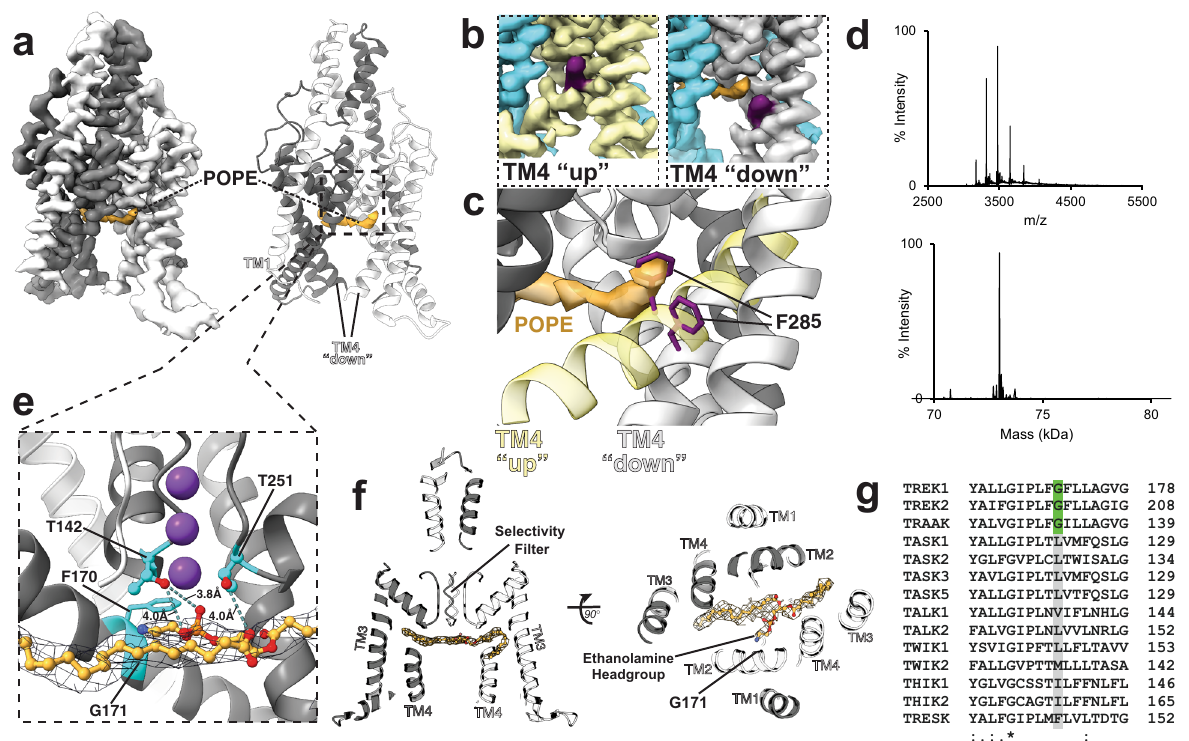
Fig. 5 | Head fi rst pore block by POPE lipids. Cryo-EM map and matching struc- tural model of TREK1 in DDM supplemented with POPE ( a ), highlighting the loca- tionofasinglePOPElipid (orange)boundwithinthe pore.The lipid densityshown isderivedfromthesharpenedmapofthe fi nalre fi nementbeforeC2symmetrywas applied,visualizedatacontourthresholdof0.0402.Azoomed-inrepresentationof the POPE binding site ( b ), highlighting the movement of the TM4 F285 residue (purple)whenthe POPEacylchaintailoccupiesthe poresite toshiftTM4fromthe “ up ” conformation (yellow, left panel) to the TM4 “ down ” conformation (white, right panel). Overlaying these two structural models ( c ) shows how the POPE molecule and the TM4 F285 residue would overlap if TM4 remained in the “ up ”